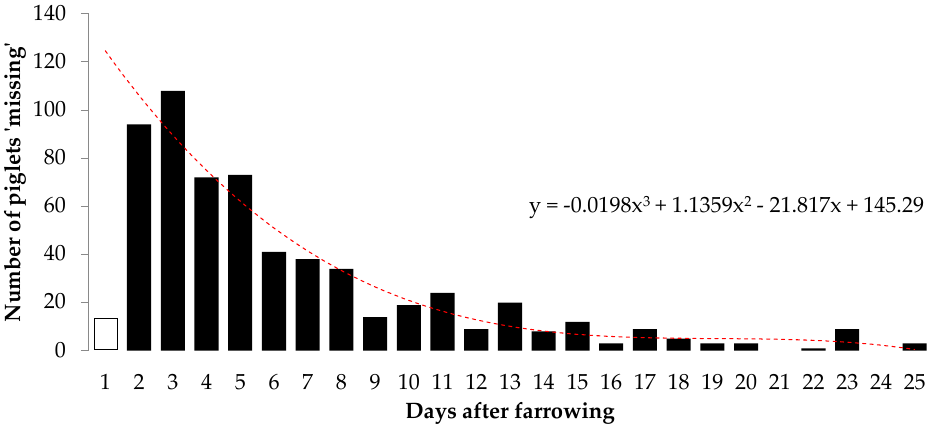
Figure 5. Distribution of records of ‘missing’ piglets by their age. Only 15 piglets were recorded as missing on their first day (white bar); however the red dotted line shows a polynomial line of best fit, which suggests that more piglets are likely lost on their first day (i.e., on the night they were born) than recorded. Animals 2016 , 6 , 60